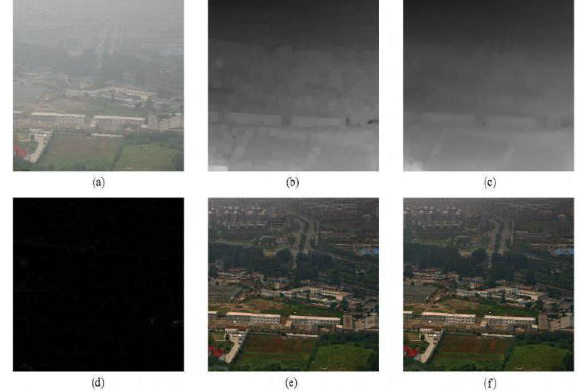
Figure 1. Dehazing photo with smooth depth variation. (a) Input image I (b) Coarse transmission map t' (c) Refined transmission